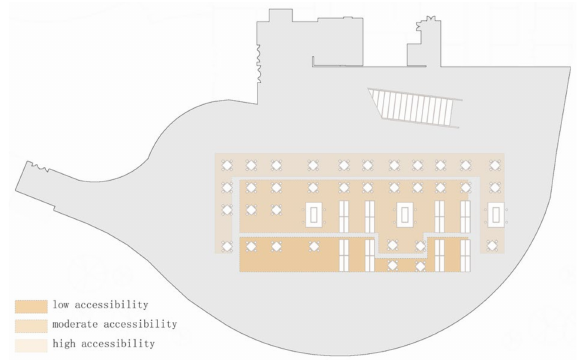
Figure 6. Schematic diagram of accessibility